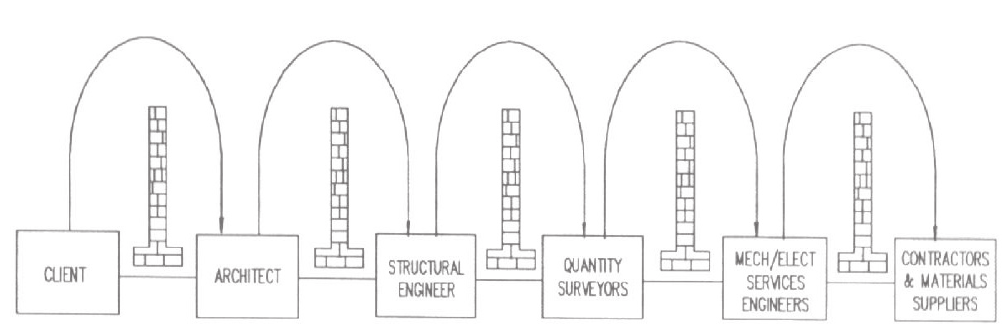
Figure 1: The over the wall approach (Evbuomwan and Anumba, 1998)